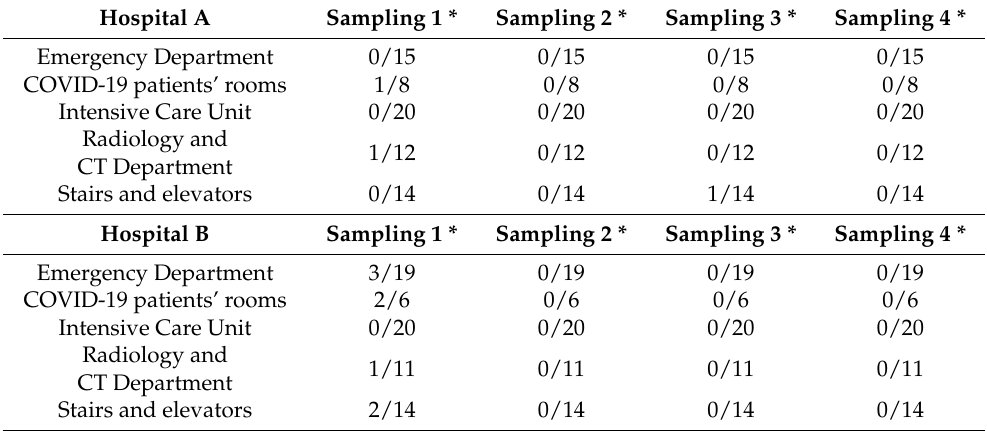
Table 3. Samples tested positive for SARS-CoV-2 by hospital, sampling site, and sampling